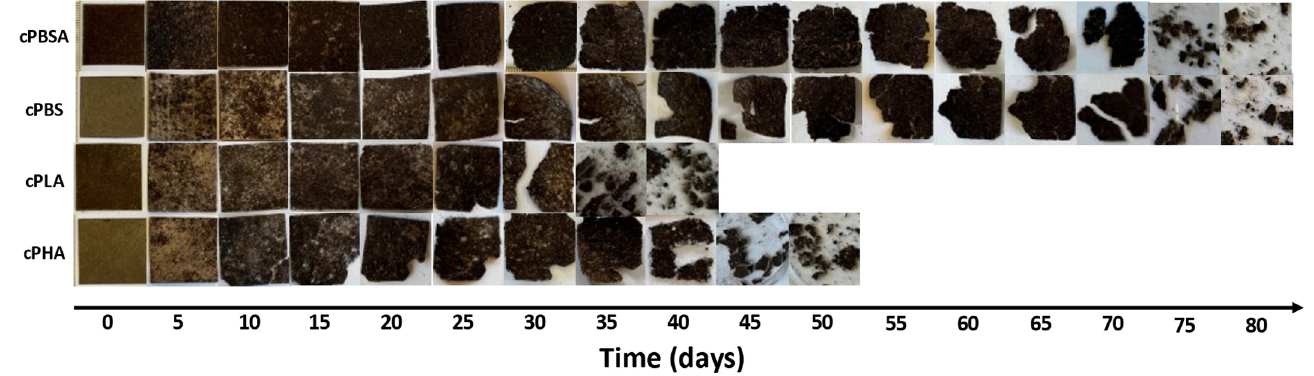
Figure 8. Photos of cPBSA1.5, cPBS1.5, cPLA1.5, and cPHA1.5 laminates during the biodegradation process in the composting conditions.